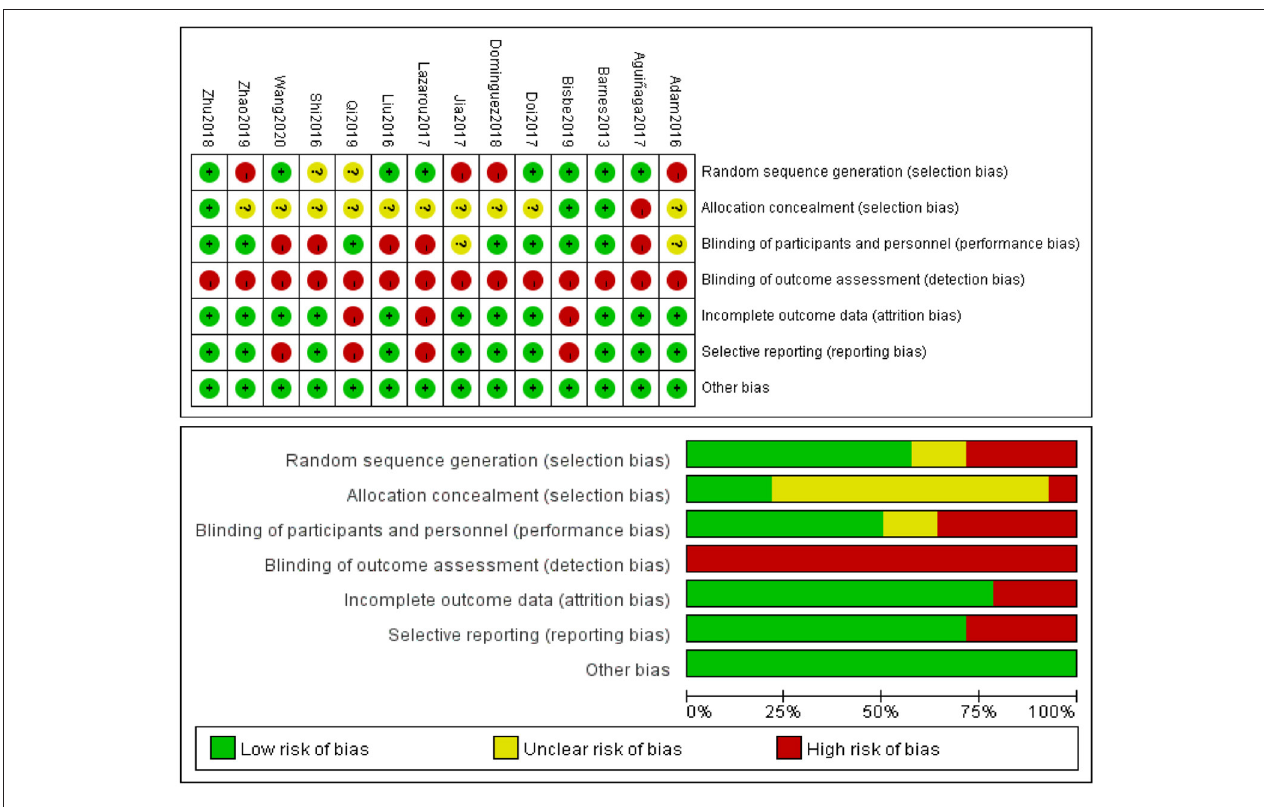
FIGURE 2 | Results of Cochrane risk of bias tool.